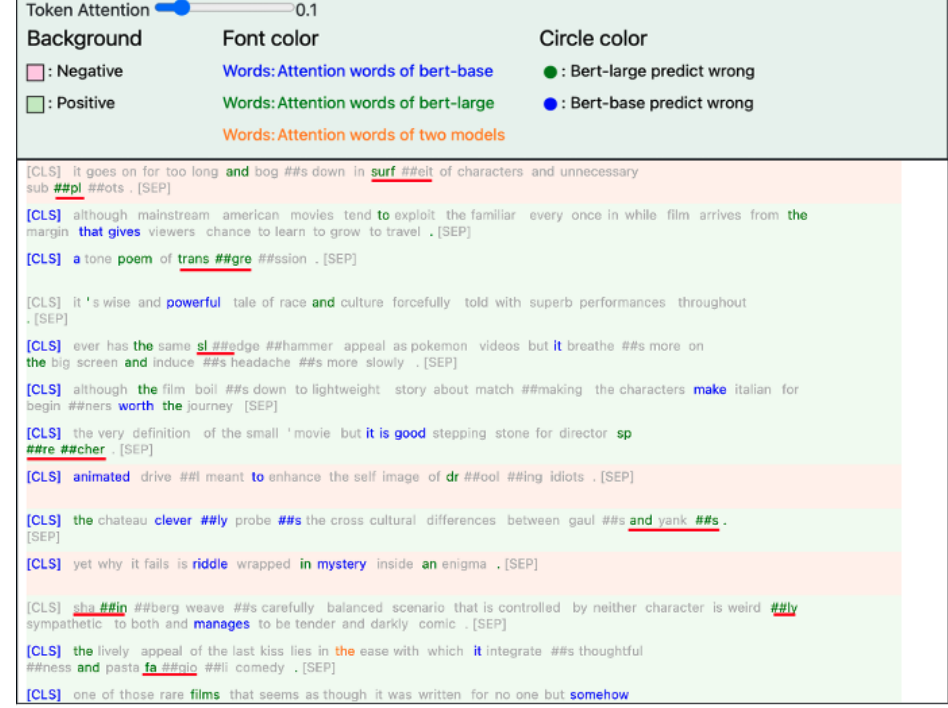
Figure 18. When showing instances with high similarity, many wordpieces are attention words of the bert-large model.